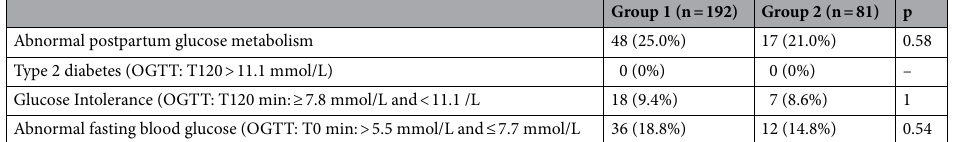
in the university hospital of Bondy (n = 9795) 9 , 27.4% in an Australian study (n = 4873) 15 , 34% in Qatar (n = 801) 17 ,